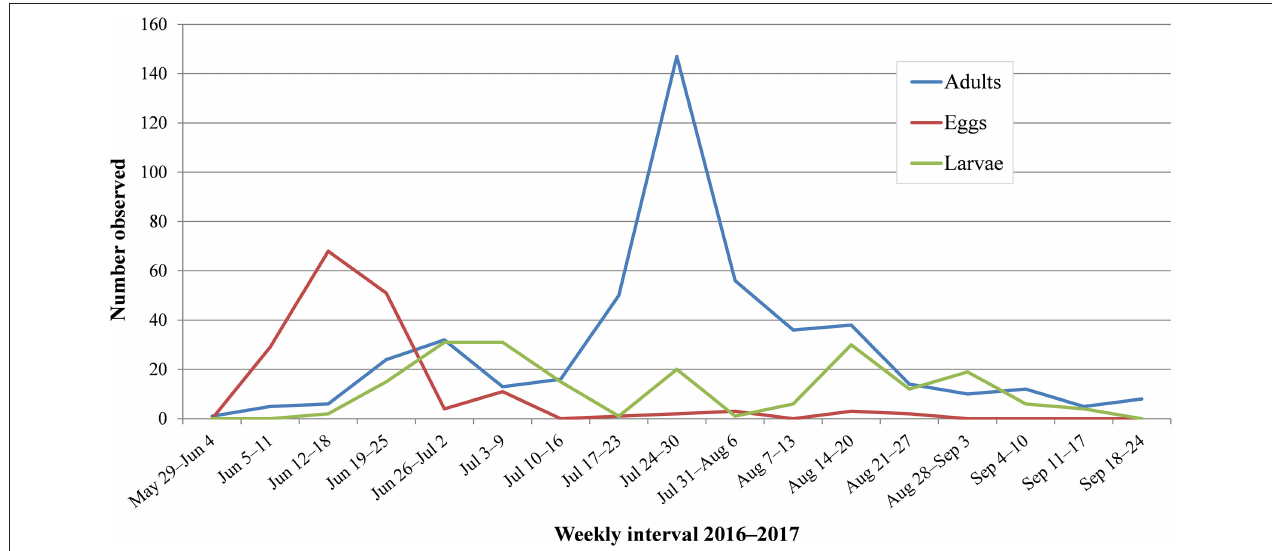
FIGURE 5 | Life stage phenology of breeding monarchs in Idaho and Washington based on survey observations ( n = 844) binned by weekly intervals in 2016–2017. Survey windows were 26 May − 1 September in 2016, and 3 June − 20 September in 2017.